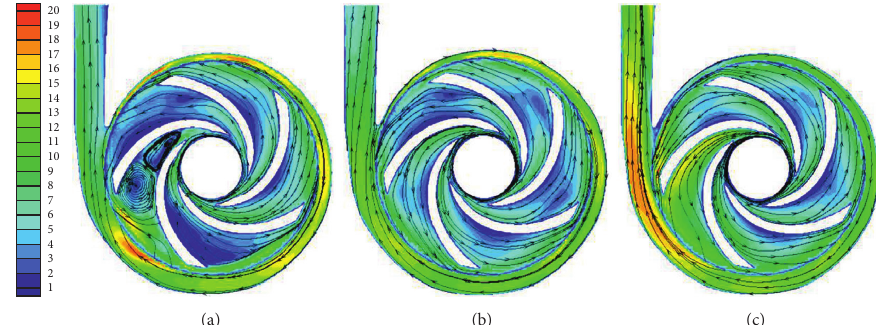
Figure 7: Velocity cloud chart and streamline chart under different working conditions. (a) 0.6Q, (b) Q, and (c) 1.4Q.